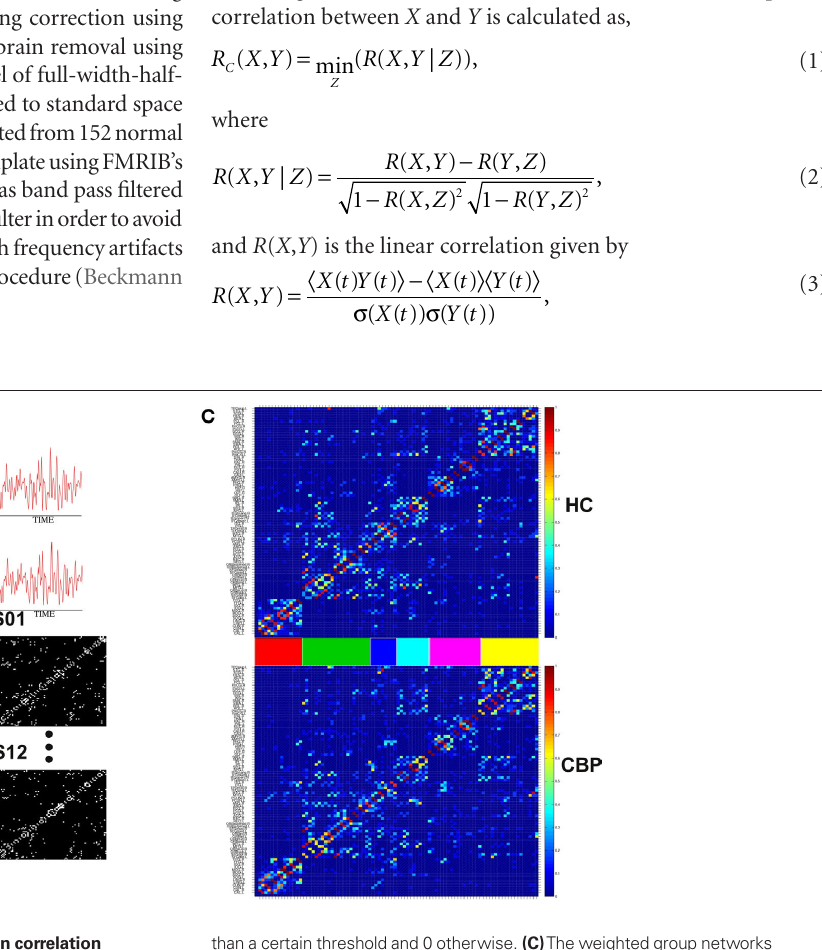
than a certain threshold and 0 otherwise. (C) The weighted group networks obtained from the correlation matrices of the healthy control (HC) (top) and chronic back pain (CBP) (bottom) subjects. The color bars between the panels identify the six communities of the HC group. Same ordering is used for the CBP